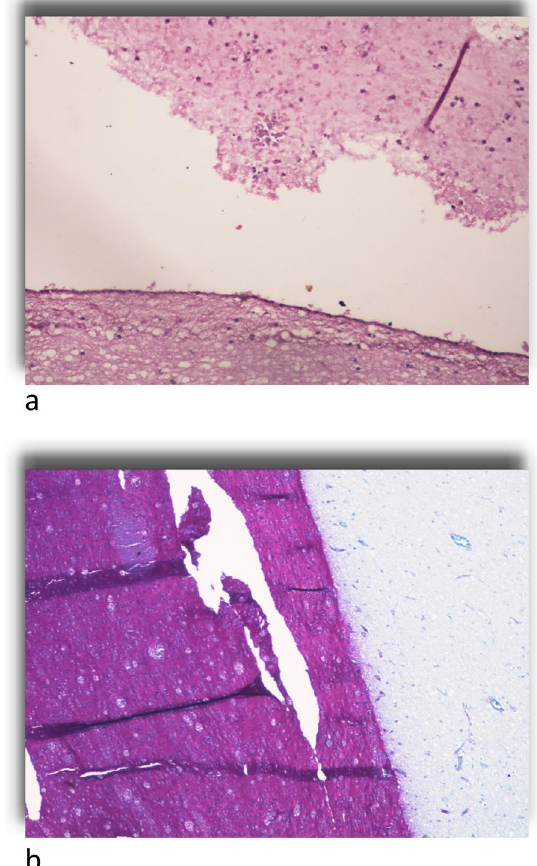
Fig. 11 a This microscopic picture stained with H&E stain showing mucinous debris in the top of the picture and brain tissue down lined by simple epithelium. b PAS stain: mucin (left) and brain tissue